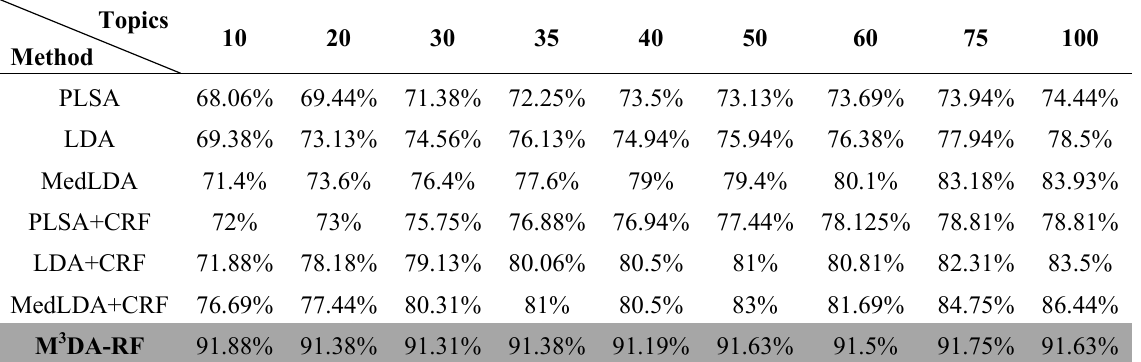
Table 1. The overall accuracies of different methods.